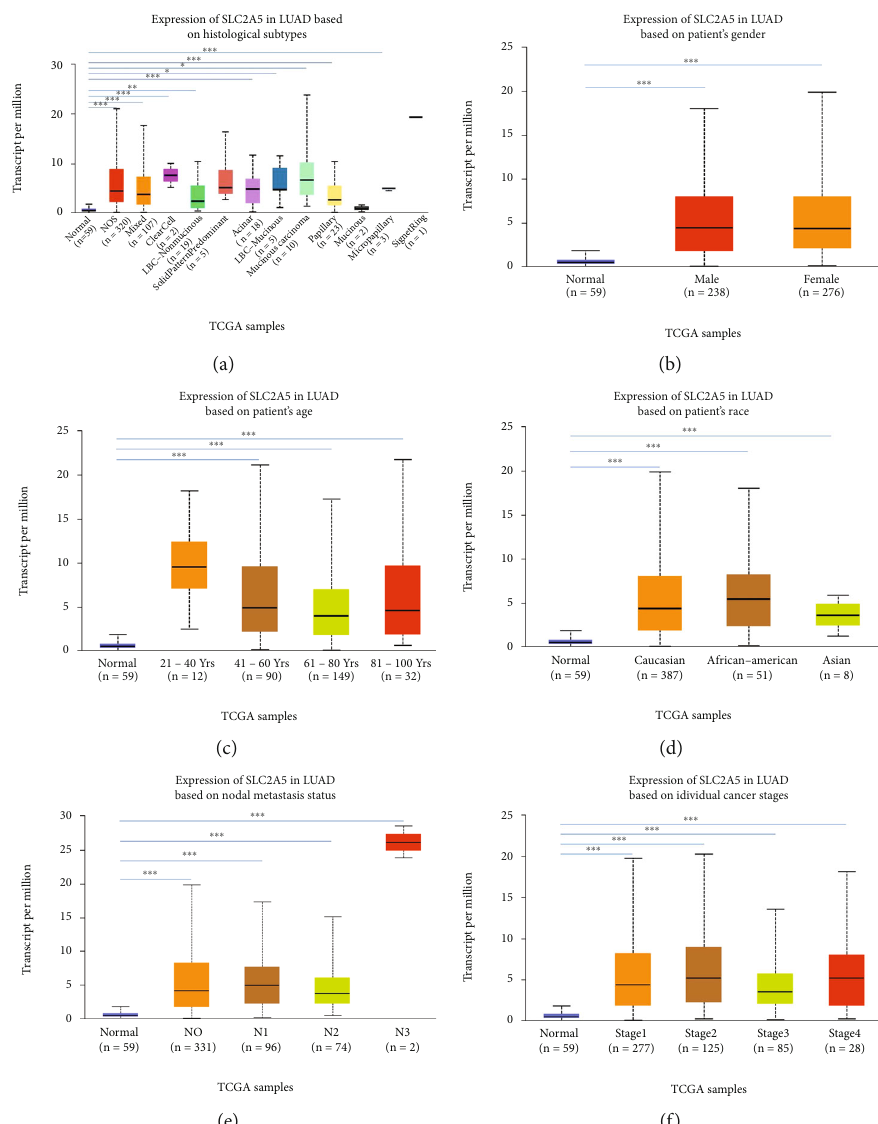
Figure 2: SLC2A5 expression in subgroups of clinical characteristics. (a) Expression of SLC2A5 in LUAD based on histological subtypes. (b) Expression of SLC2A5 in LUAD based on patient ’ s gender. (c) Expression of SLC2A5 in LUAD based on patient ’ s age. (d) Expression of SLC2A5 in LUAD based on patient ’ s race. (e) Expression of SLC2A5 in LUAD based on nodal metastasis status. (f) Expression of SLC2A5 in LUAD based on individual cancer